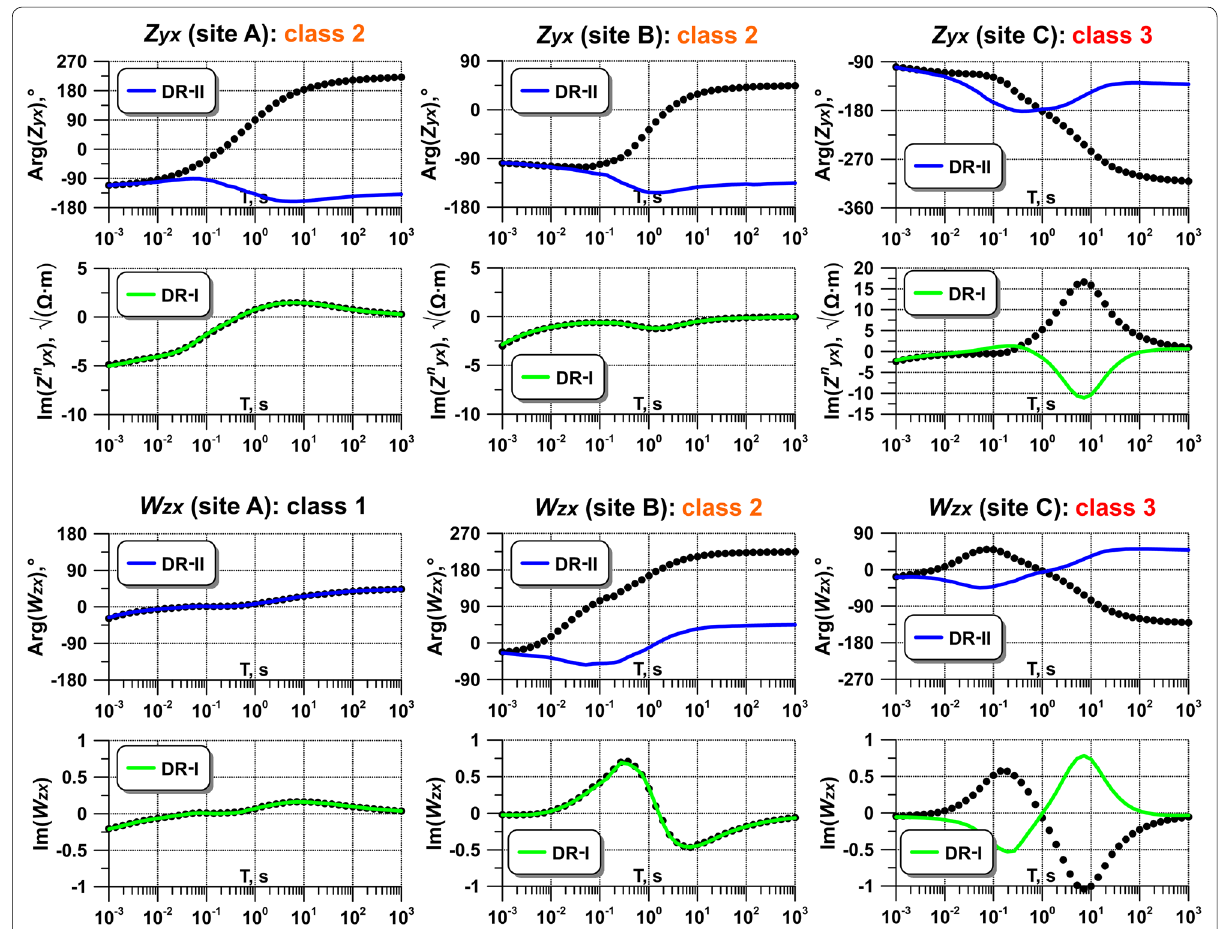
Fig. 13 The DR validity in Z yx and W zx components observed in MT sites A, B and C over the SL-form